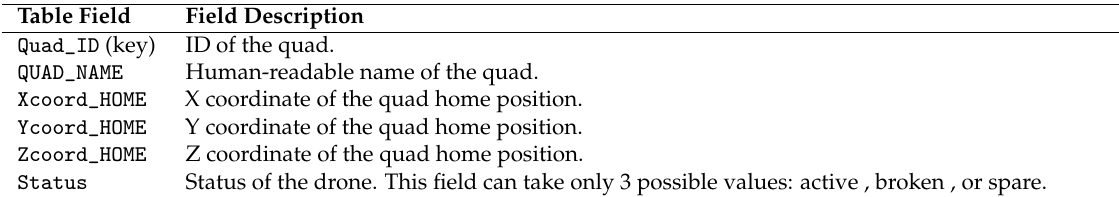
Table 1. Definition of the table “Quads”. Table Field Field